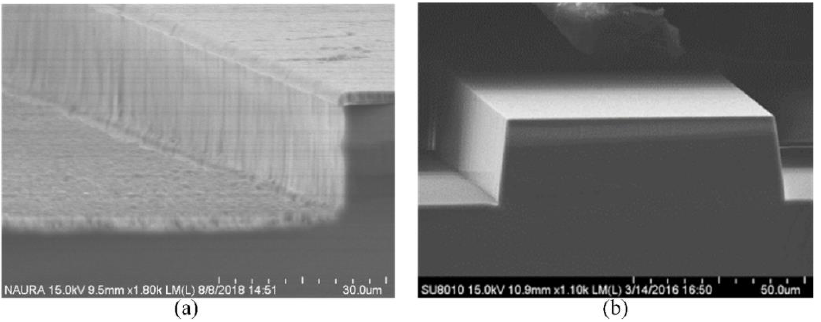
Figure 15. ( a ) The SEM image of the etched surface without clean step; ( b ) the SEM image of the etched surface with clean step. Table 5. The parameters of clean step.